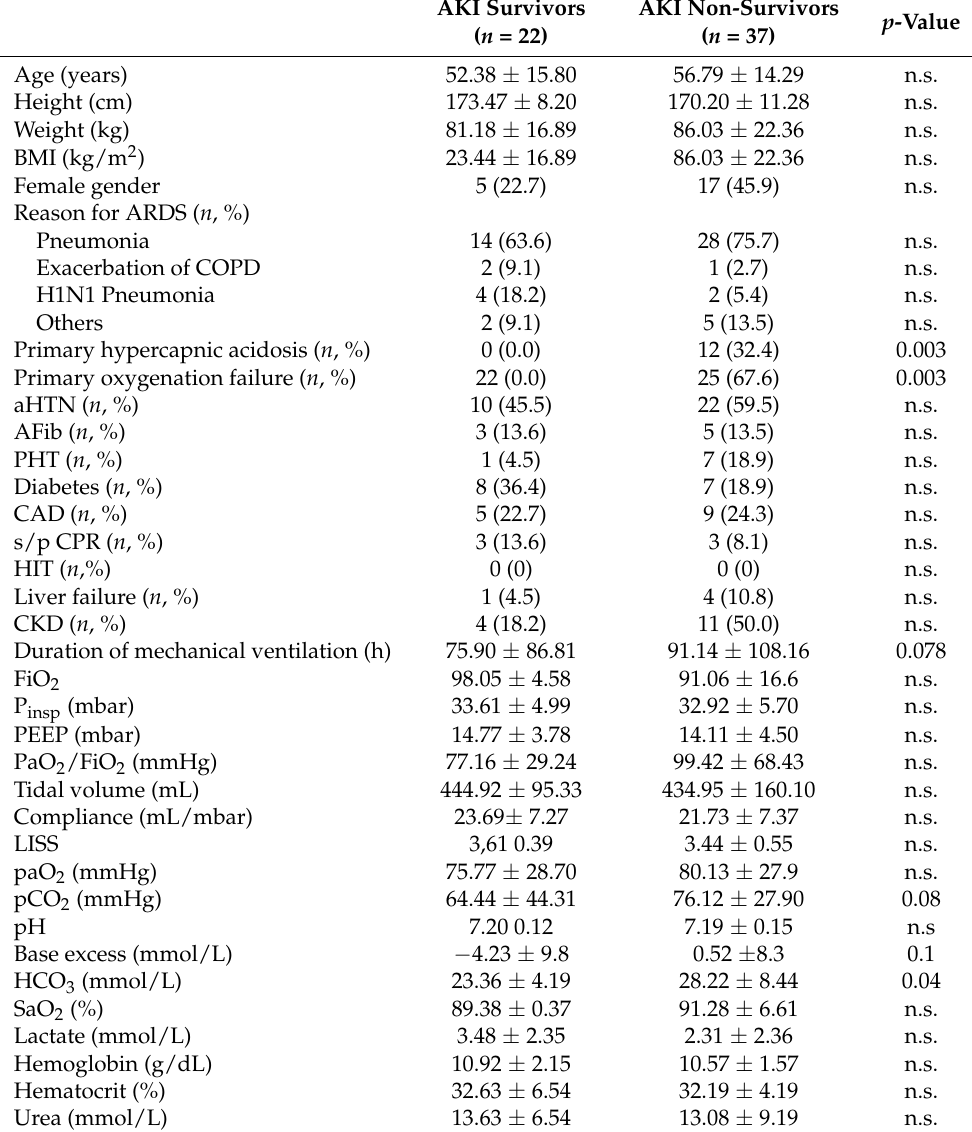
Table 4. Patients’ clinical and laboratory pre-ECMO characteristics, between AKI survivors and AKI